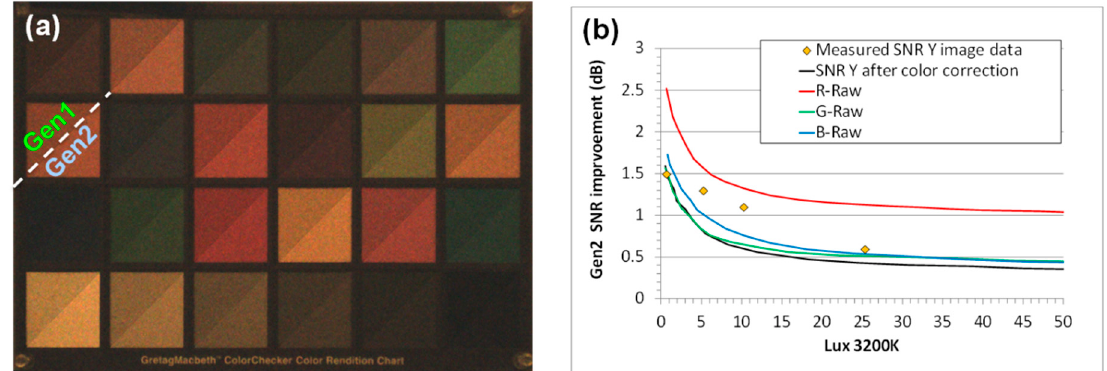
Figure 11. ( a ) Combined Macbeth chart images from 16 MP, 1 µm pixel Gen1 and Gen2 products to show the Gen2 low light (5 Lux) sensitivity improvement. ( b ) Gen2 SNR improvement vs. lux level, including measured data and simulated results (F2.0, 15 fps).